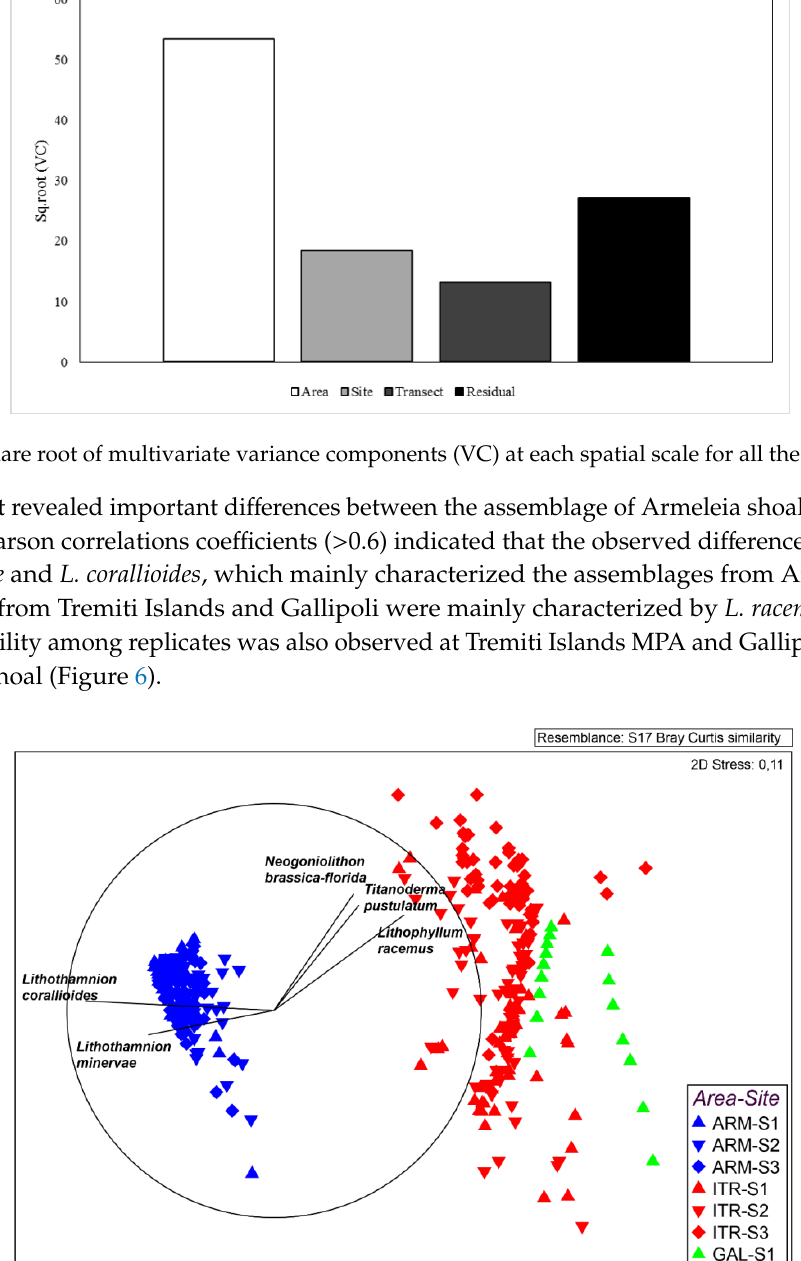
Figure 7. Multivariate dispersion (PERMDISP). Patterns of variability of algal assemblages: ( a ) across transects and ( b ) within sites, split for the different areas (ARM: Armeleia shoal; ITR: Tremiti Islands; GAL: Gallipoli, where a rhodolith bed was found only in one of the three study sites). Error bars represent standard error.